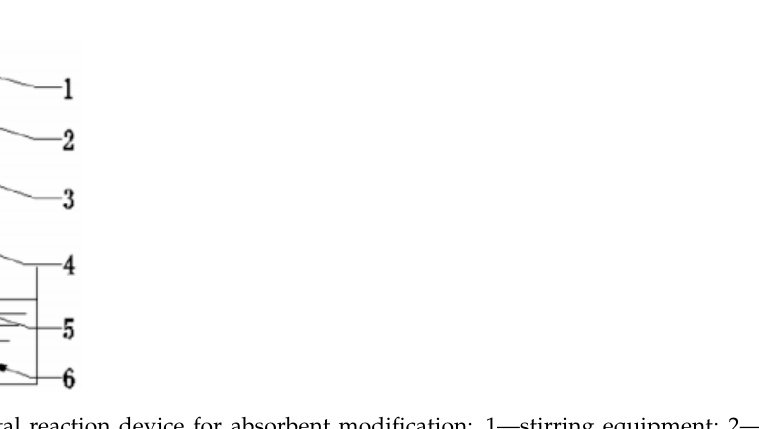
Figure 2. Experimental reaction device for absorbent modification: 1—stirring equipment; 2— condenser; 3—temperature; 4—blender; 5—three-necked flask; 6—oil bath.